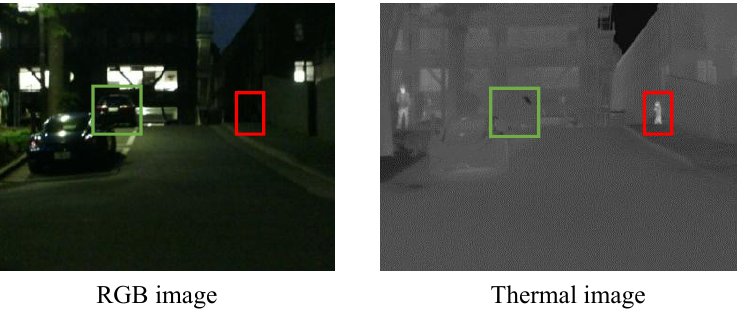
Figure 1. Illustration of the aligned multi-spectral images, where the RGB image and thermal image can provide complementary information for each